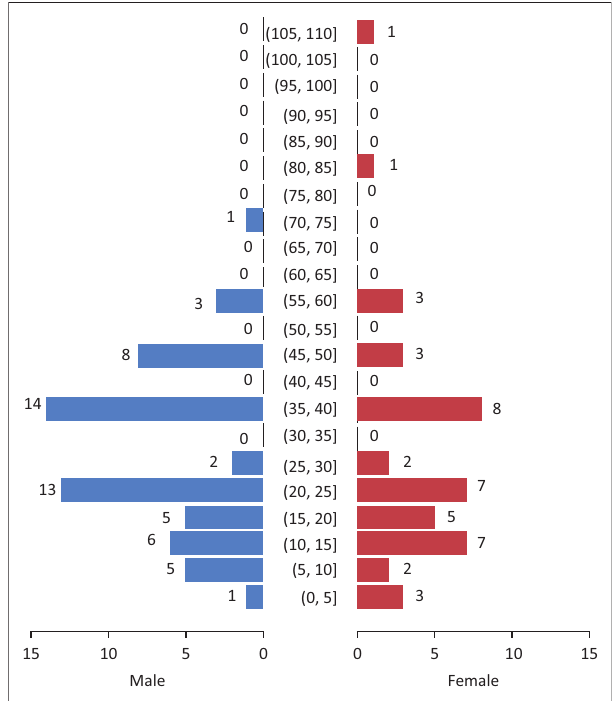
FIGURE 2: Population pyramid showing the age in months according to dog erythrocyte antigen 1.1 status in dogs sampled from Chinamhora.